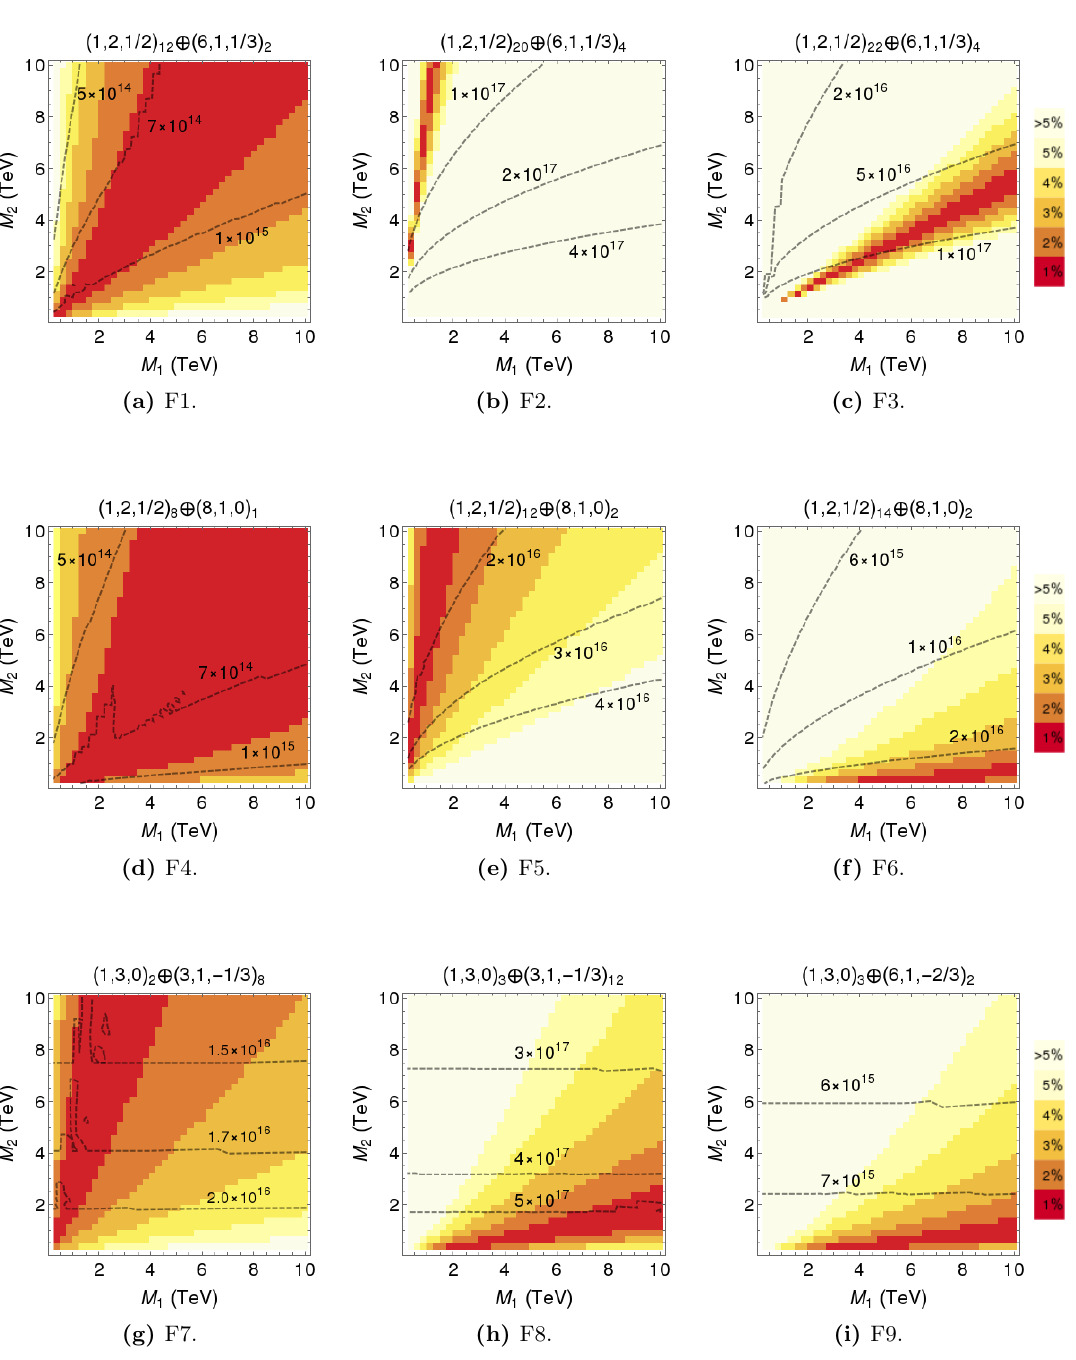
Figure 1. Distribution of the mismatch parameter (cid:15) GUT as a function of M 1 and M 2 for the scenarios F1{F9 of table 3. Red area corresponds to the PGU ( (cid:15) GUT (cid:20) 1%). Di(cid:11)erent shades of yellow illustrate departure from the precise uni(cid:12)cation condition as quanti(cid:12)ed by the increasing values of (cid:15) GUT . Isocontours of the uni(cid:12)cation scale (in GeV) are indicated as dashed black curves.